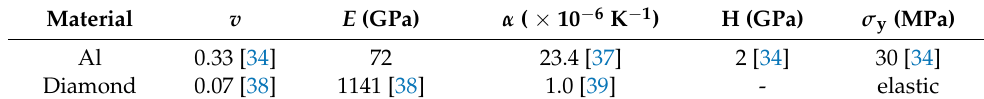
Table 3. Material properties of diamond and Al used in the calculation of plastic strain.